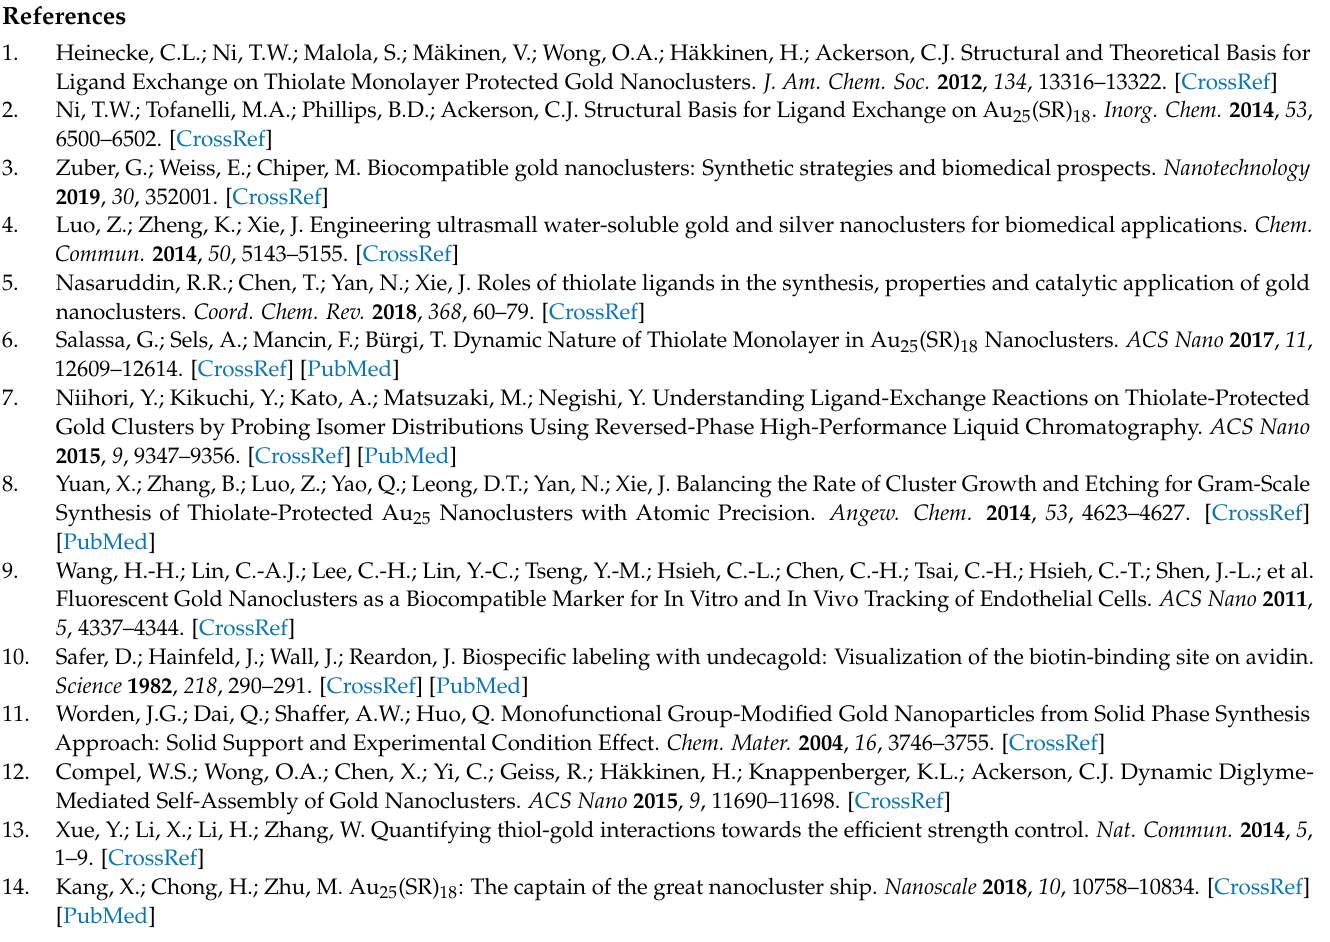
Supplementary Materials: Supplemental Figure S1: TBE-PAGE separation of nanocluster products; Supplemental Figure S2: Full ESI-MS spectra; Supplemental Figures S3 and S4: Ligand exchange with 3-mercaptopropionic acid;-S4, Supplemental Table S1: Peak Assignments from Full Spectra; and Supplemental Table S2: Observed nanocluster mass and potential